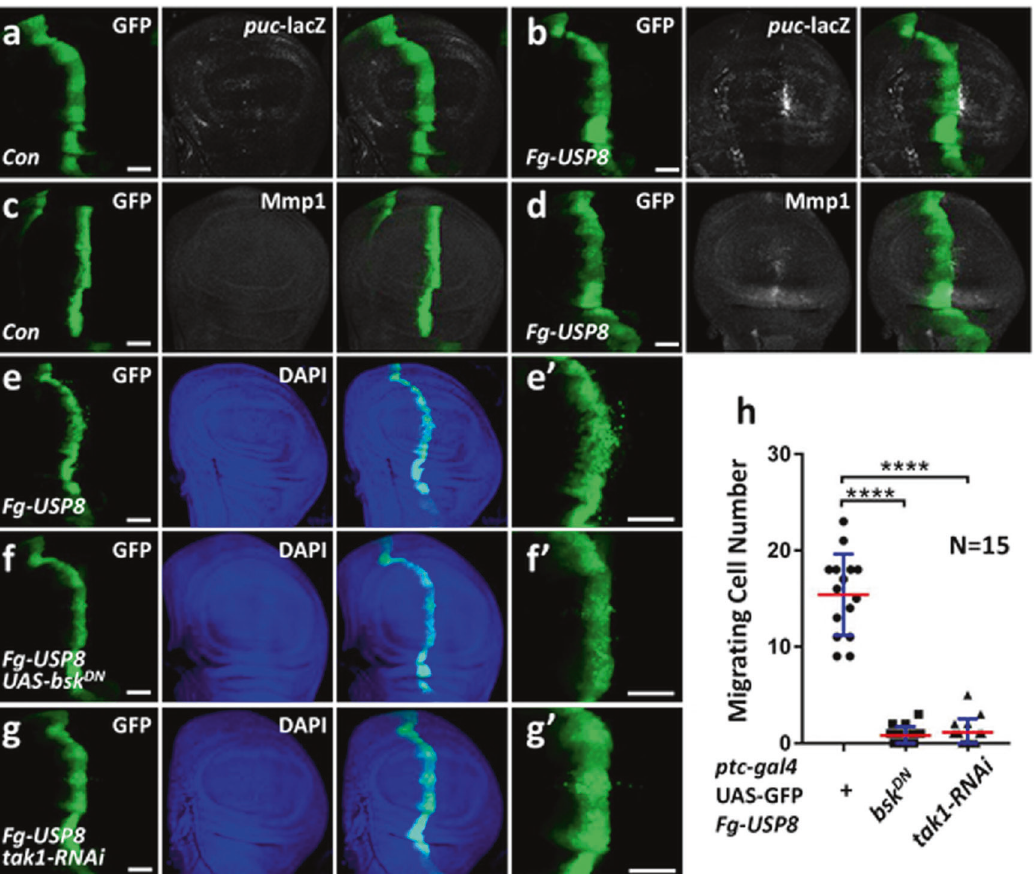
Fig. 6 Human USP8 can replace Drosophila Usp8 to modulate the JNK pathway. a A control third-instar larvae wing disc expressing GFP under ptc -gal4 driver was stained to show GFP (green) and puc -lacZ (white). b Misexpression of USP8 increased puc -lacZ. c A control wing disc expressing GFP under ptc -gal4 driver was stained to show GFP (green) and Mmp1 (white). d Overexpression of USP8 increased Mmp1 protein. e Overexpression of USP8 driven by ptc -gal4 induced cell migration from A/P boundary to posterior. GFP (green) represents the expression regions of ptc -gal4 in the wing disc. e' was an enlarged fi gure of e . f Overexpression of bsk DN could block USP8 -induced cell migration. g Knockdown of tak1 inhibited USP8 -induced cell migration. h Quanti fi cation analyses of migrating cell numbers in e – g ( N = 15). Above all, the t -test was used for statistical analyses, **** p < 0.0001. Scale bars: 50 μ m for all disc